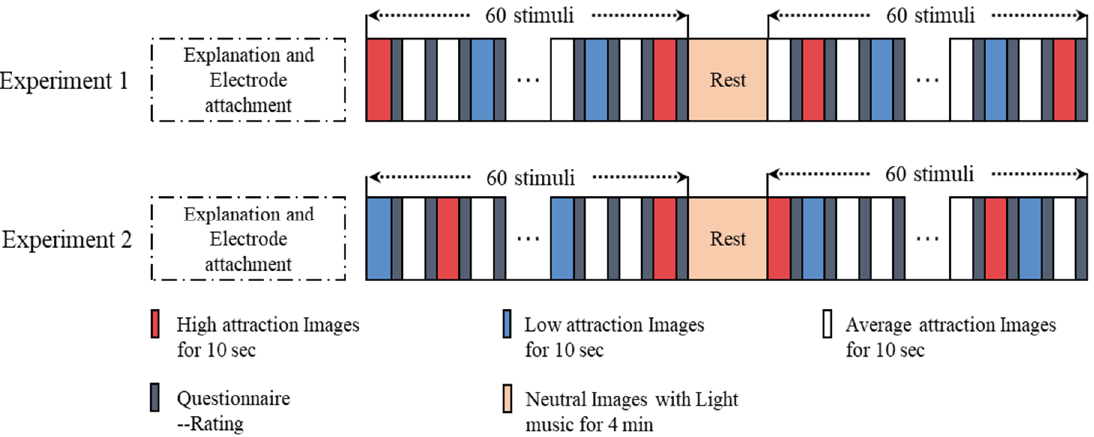
Figure 1. Impulse of love at first sight (ILFS) emotion-induced experimental procedure.